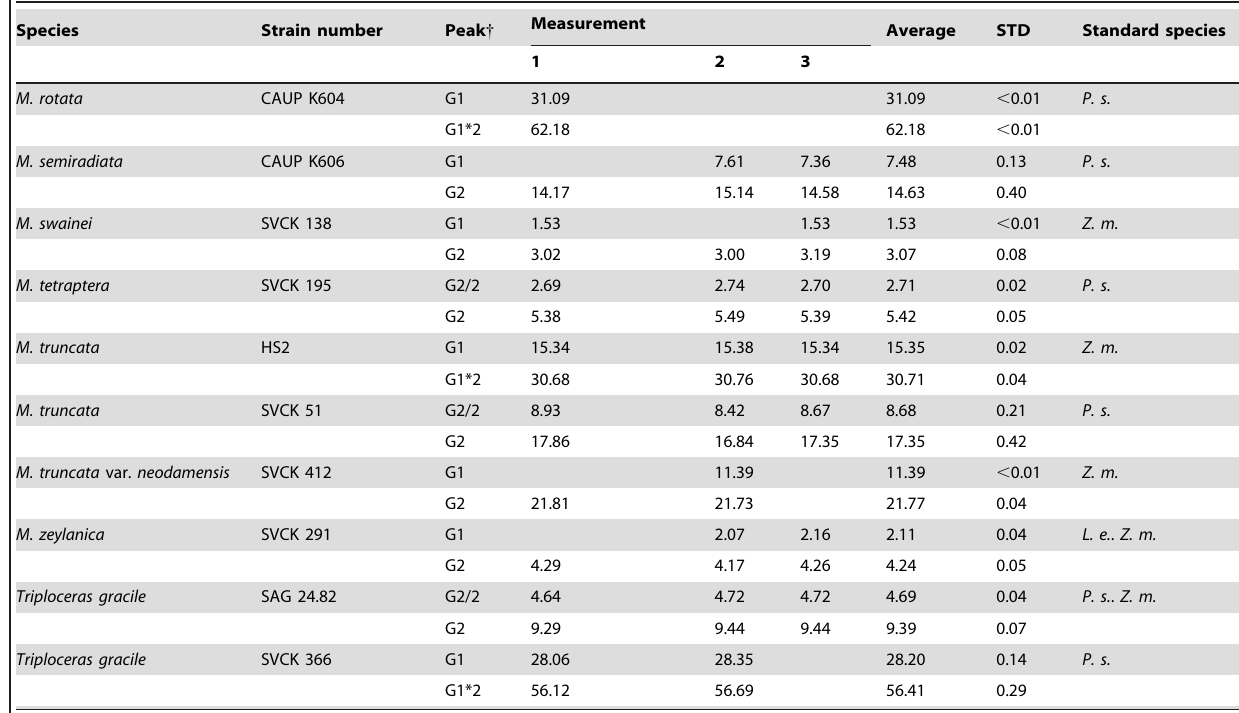
Species Strain number